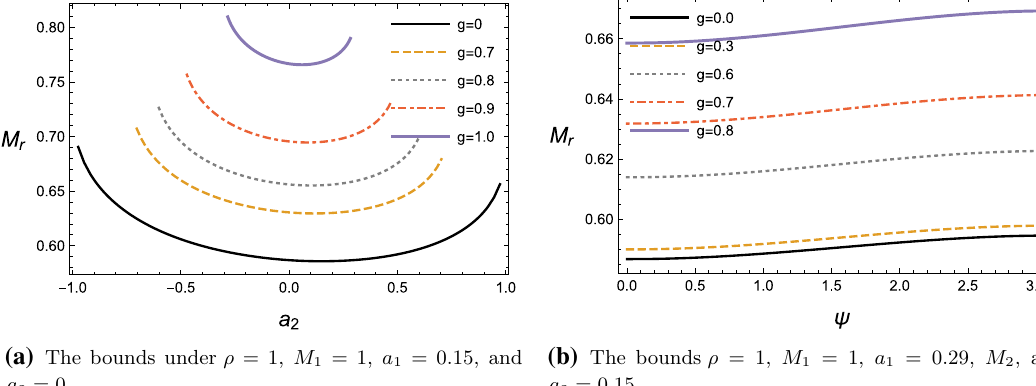
Fig. 14 The upper bound on the radiation with respect to g